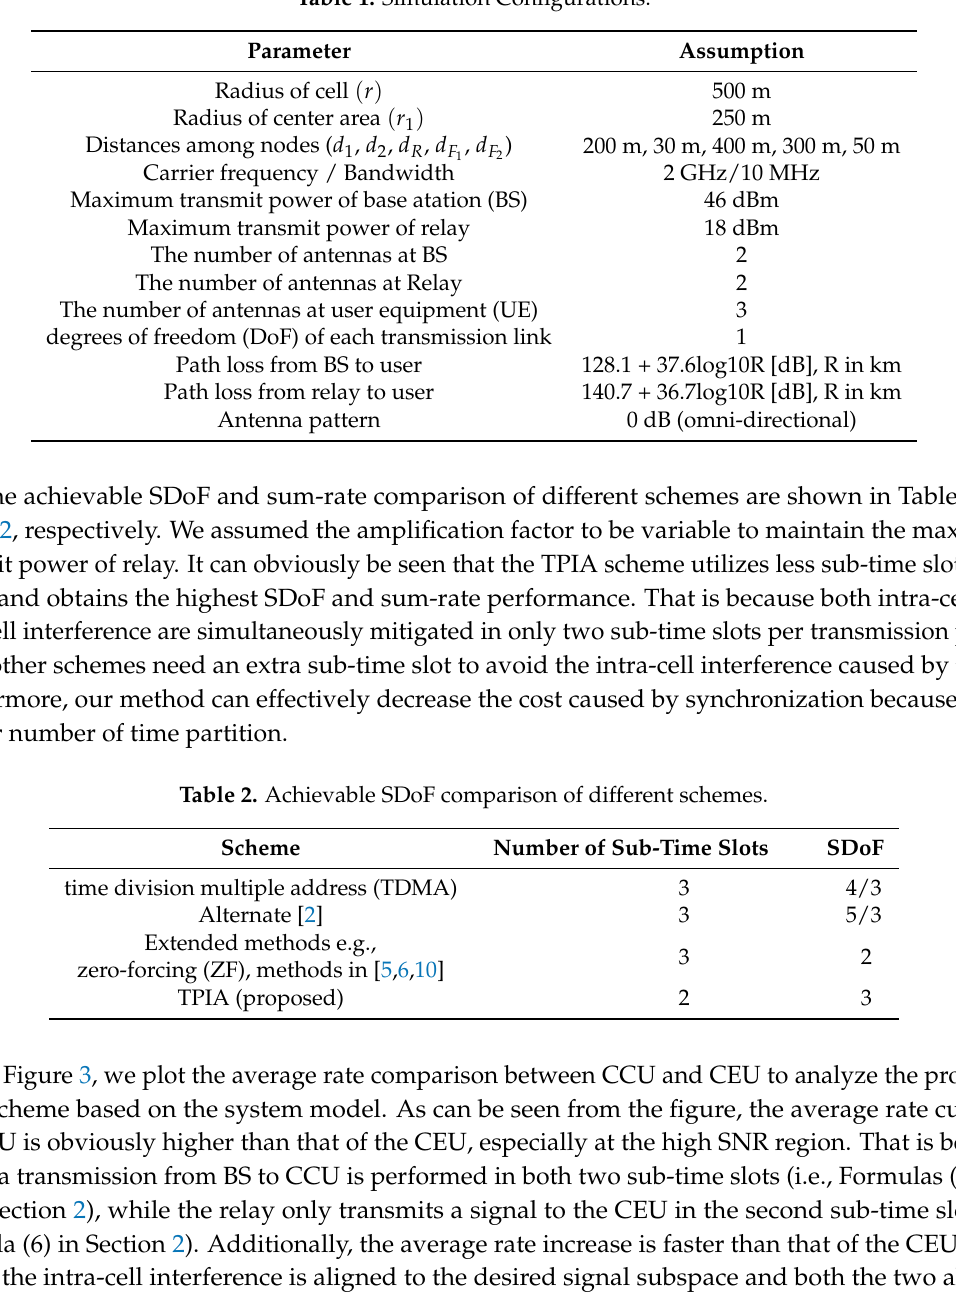
Table 1. Simulation Configurations.